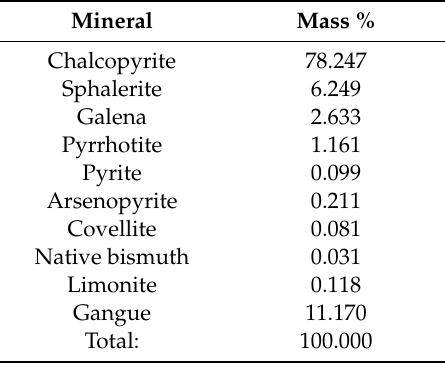
Table 2. Mineral composition of the chalcopyrite concentrate [56].